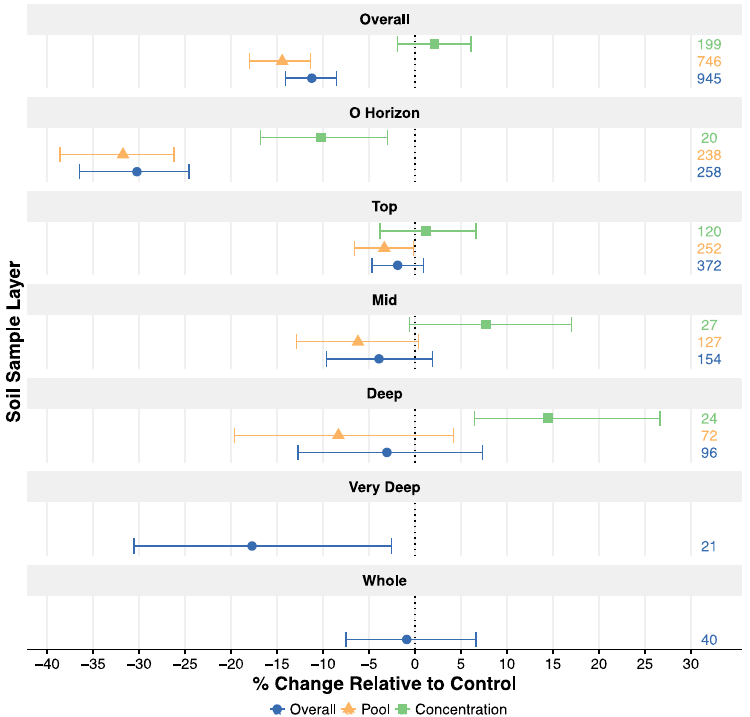
Figure 1. Response of soil C to forest harvesting, overall and faceted by soil depth. All points are back-transformed mean effect sizes ± 95% confidence intervals calculated by nonparametric bootstrap. The number of response ratios ( k ) that make up each mean effect is listed on the right. Mean effects with confidence intervals overlapping the dashed line (0%) show no significant change in soil C due to harvesting. Within each facet, mean effect sizes are shown for the overall effect as well as separately for studies reporting C pool units or concentration units.